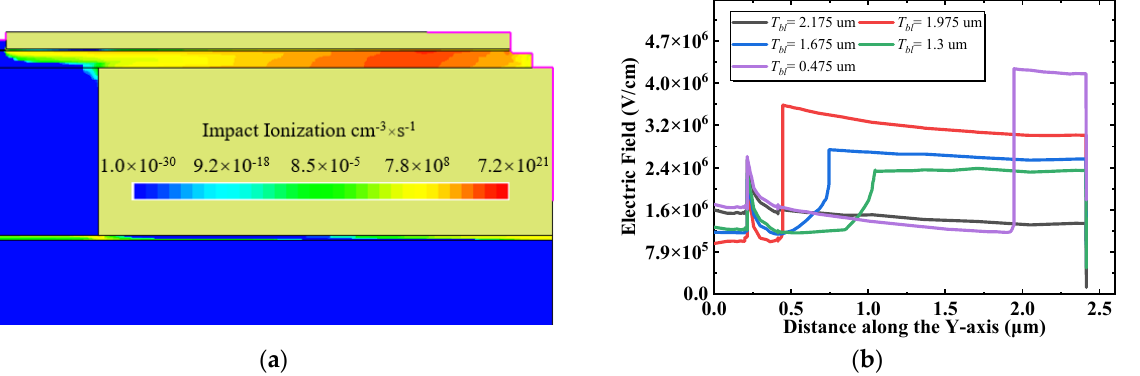
Figure 9. ( a ) Vertical electric field distribution versus distance along the Y -axis for various Si 3 N 4 buried layer thicknesses. ( b ) Impact ionization rate with a buried layer thickness of 2.175 μ m. The SiN x passivation layer on the surface of the device is widely utilized to suppress the current collapse, and the interface states between the SiN x and AlGaN barrier layers have been broadly investigated [32–35]. The existence of donor-type traps between the interface has been demonstrated, and in the proposed BP-HEMT, donor-type traps are introduced correspondingly at the interface between the AlGaN buffer and Si 3 N 4 buried layer during fabrication. To further analyze the effect of interfacial donor traps on the breakdown performance of the device, a fixed energy level interfacial donor trap is set between the SiN x and AlGaN simultaneously during the simulation. Figure 10a shows the dependence of BV and FOM on the interface trap concentration ( N trap ) of the AlGaN buffer region and Si 3 N 4 buried layer. The BV and FOM increase rapidly and then stabilize as N trap increases. To analyze the reasons, Figure 10b shows the vertical electric field at x = 6.0 µ m in the off state with a drain voltage of 600 V, and for the same reason as Figure 9a, the region below the nucleation layer is not plotted. The trap located at the interface of the AlGaN buffer and Si 3 N 4 buried layer is farther away from the channel, without affecting the concentration of 2DEG, and it is quite distinct from the passivation layer trap. Therefore, the vertical electric field peak at the channel (the first peak in Figure 10b) is not affected by N trap . The electric field at the interface between the AlGaN buffer and the Si 3 N 4 buried layer (the second peak in Figure 10b) and the magnitude of the electric field in the Si 3 N 4 buried layer increase significantly with increasing N trap . The reason for this variation is that the high concentration donor leaves more positive fixed charges at the interface after ionizing the electrons, and more electric field lines pass through the Si 3 N 4 buried layer to the interface from the edge of the DC field plate. With an increased electric field in the Si 3 N 4 buried layer, the voltage sustaining capability of the whole device is increased significantly. The above analysis shows that the device performance does not deteriorate even if there is a higher N trap due to the lattice and thermal mismatch, and the proposed BP-HEMT shows superior process tolerances.